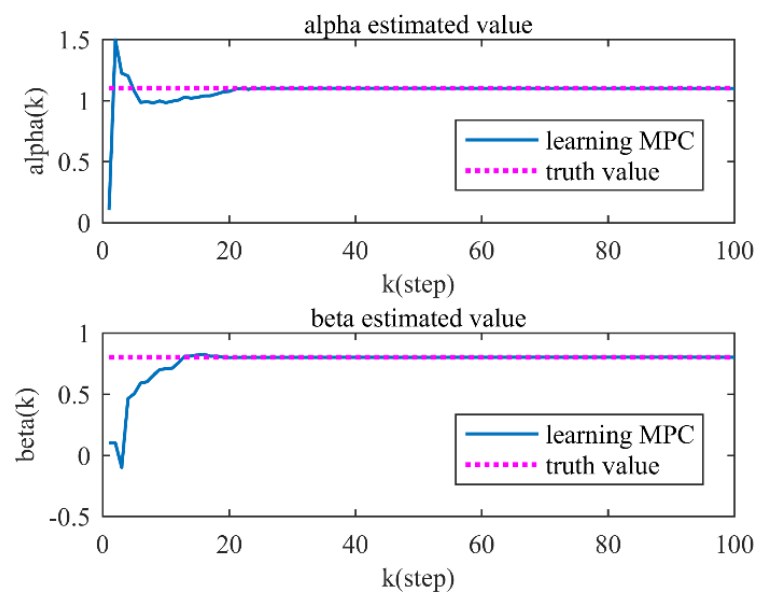
Figure 3. Estimated and true values when parameters α ( k ) and β ( k ) are constant.